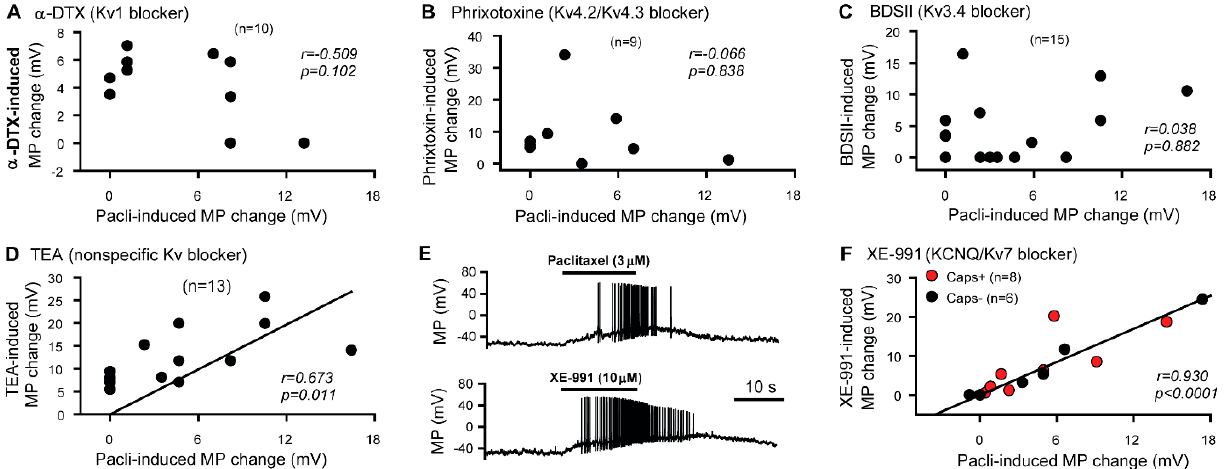
Figure 1. Relationship between the paclitaxel- and Kv channel blocker-induced membrane depolar- ization of dorsal root ganglion (DRG) neurons. ( A ) Membrane potential changes induced by 100 nM α -dendrotoxin and 3 µ M paclitaxel. r = − 0.509, p = 0.102, Spearman rank order test. ( B ) Membrane